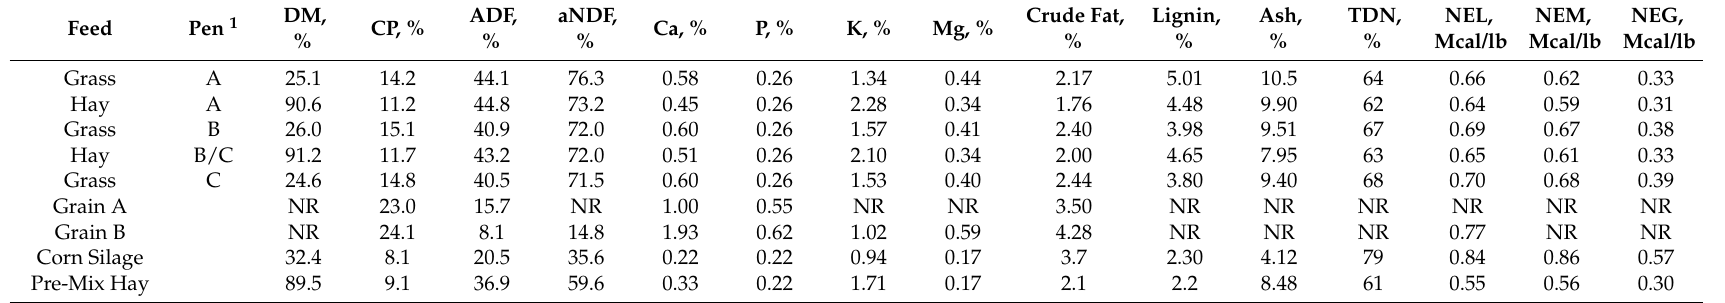
Table 1. Nutrient analyses of pastures, hay, grain and corn silage fed during the study period on a dry-matter basis. Feed